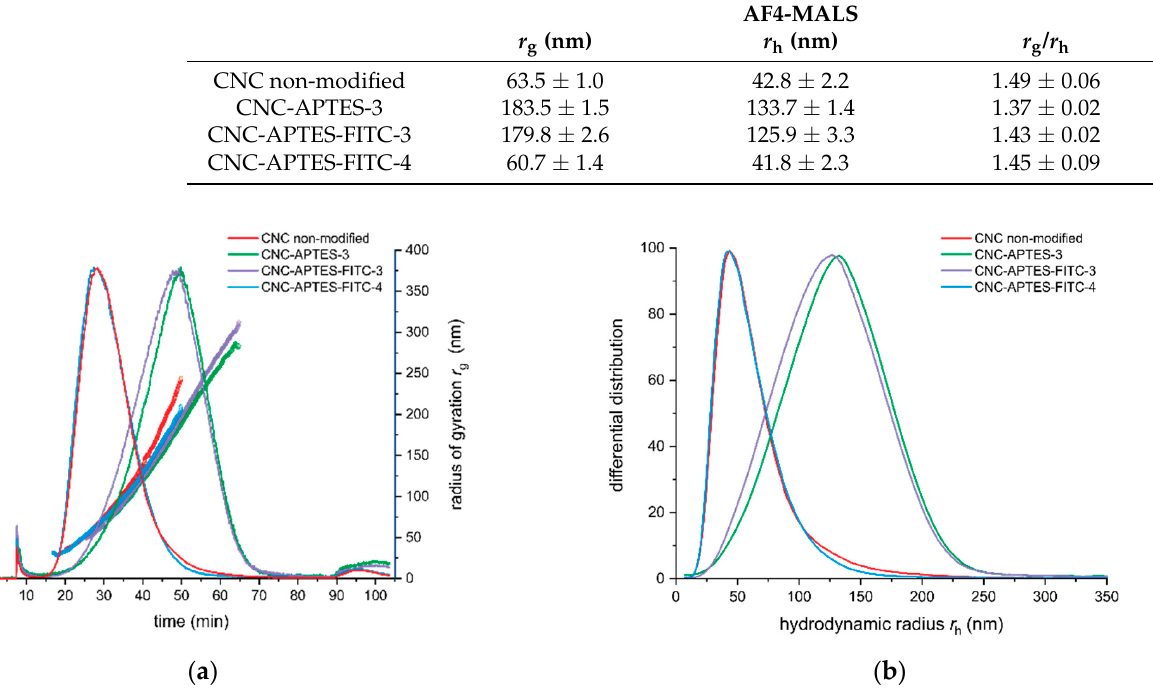
Figure 4. AF4-MALS ( a ) elution profile: MALS 92° signal (line plot) and radius of gyration r g (scatter plot) ( b ) r h size distribution.